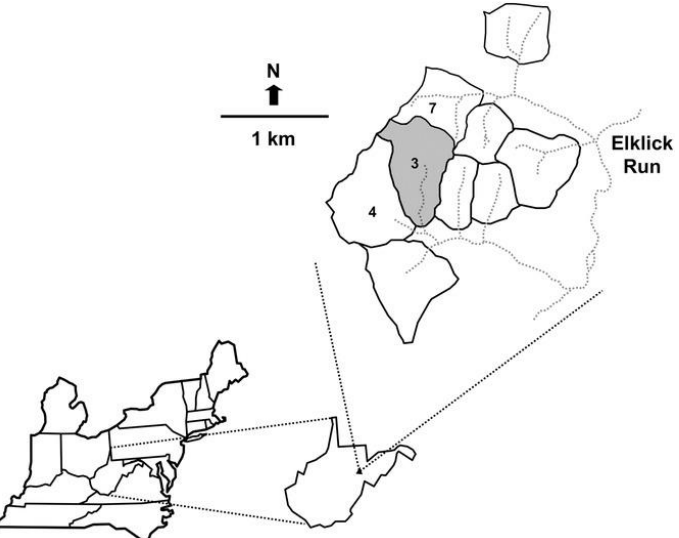
Figure 4. Map depicting watersheds of the Fernow Experimental Forest, West Virginia, USA. WS4 is the long-term reference watershed, WS3 is the treated watershed as part of the Watershed Acidi- fication Study, and WS7 is an additional reference watershed of stand age similar to that of